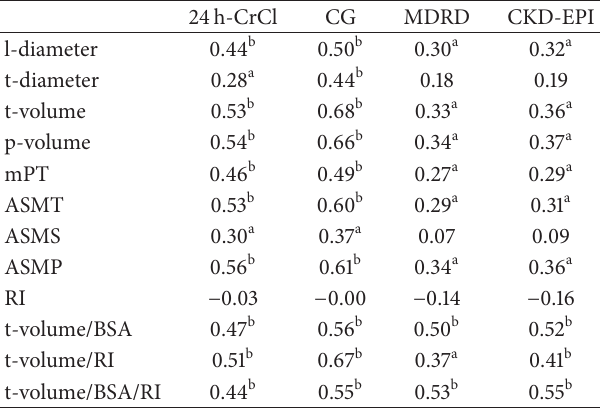
Table 4: Spearman’s correlation between kidneys ultrasound data and renal function.